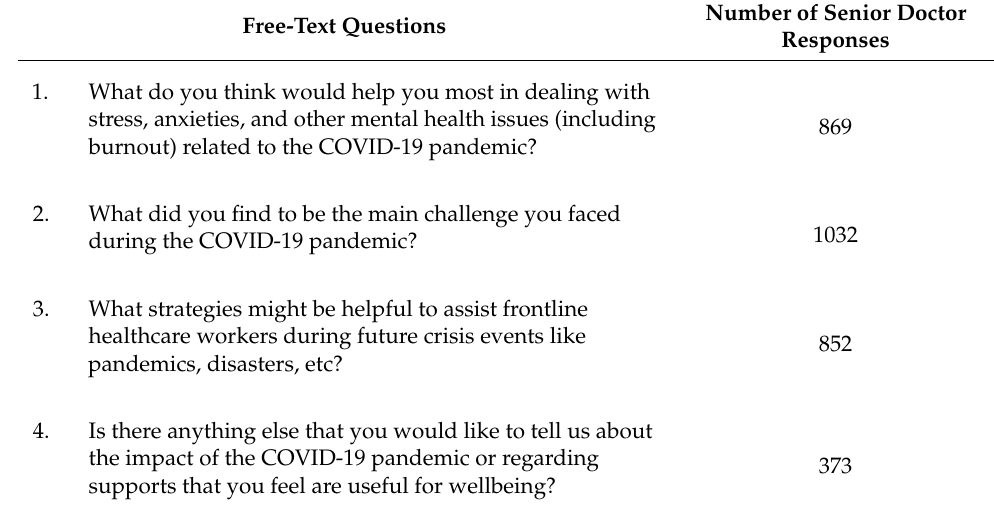
Table 1. Free-text survey